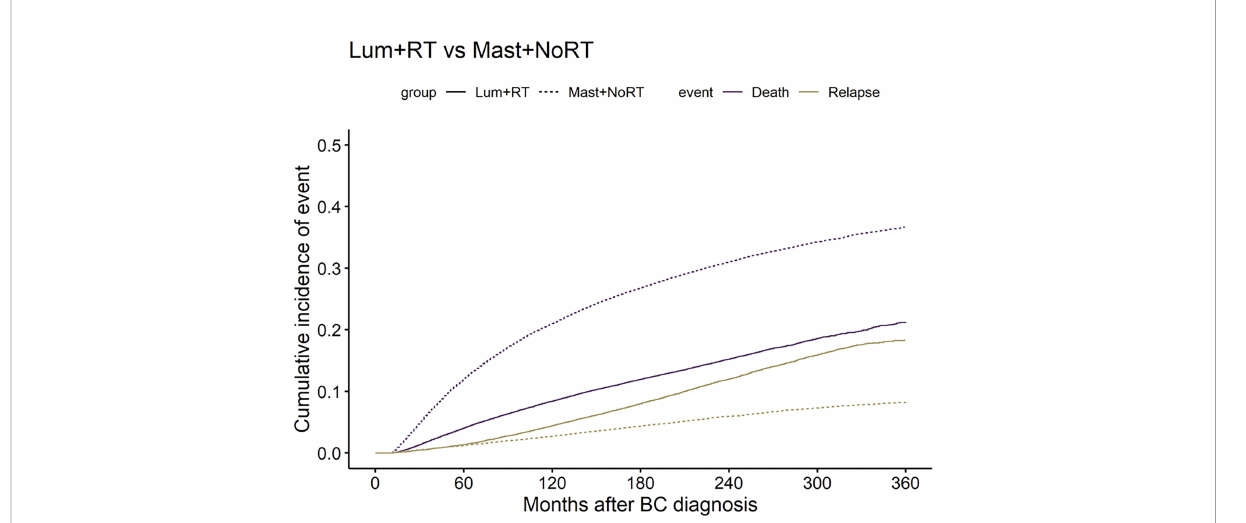
FIGURE 1 Comparisons of cumulative incidence of breast cancer recurrence (BCR) and breast cancer-speci fi c death (BSD) between patients who received lumpectomy with adjuvant radiation (Lum + RT) and patients received mastectomy without radiation (Mast + NoRT). The solid lines represent Lum + RT, the dotted lines represent Mast + NoRT; The yellow lines represent BCR, the purple lines represent BSD. BC, breast cancer.